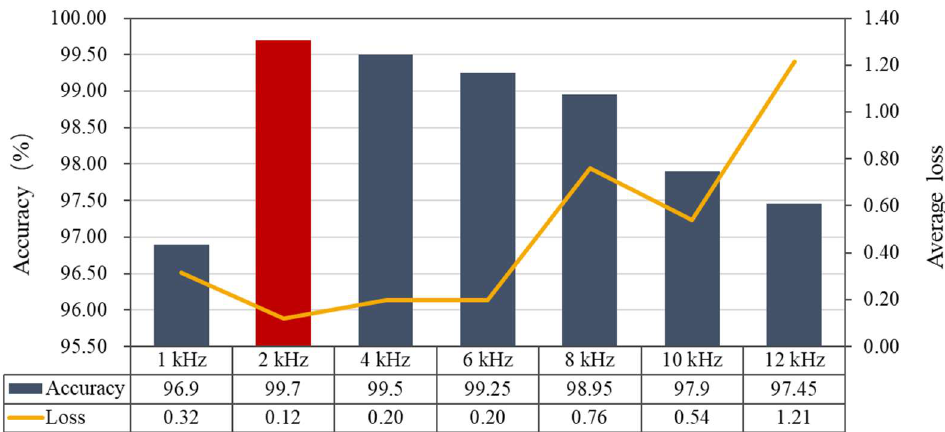
Figure 12. The average accuracy and loss of different frequencies on dataset A.